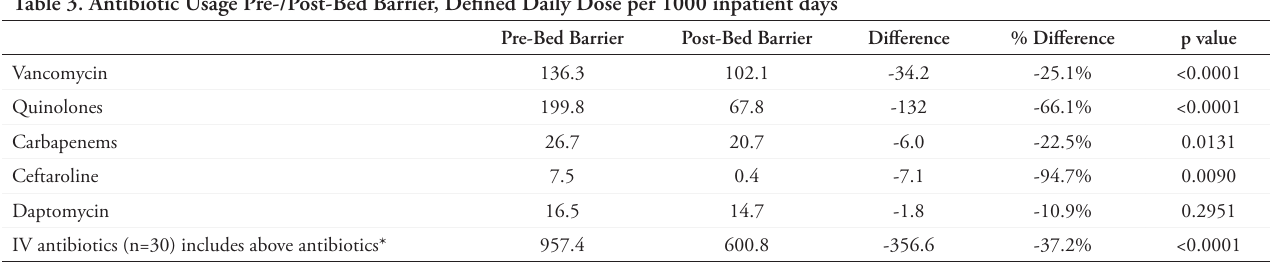
Table 3. Antibiotic Usage Pre-/Post-Bed Barrier, Defined Daily Dose per 1000 inpatient